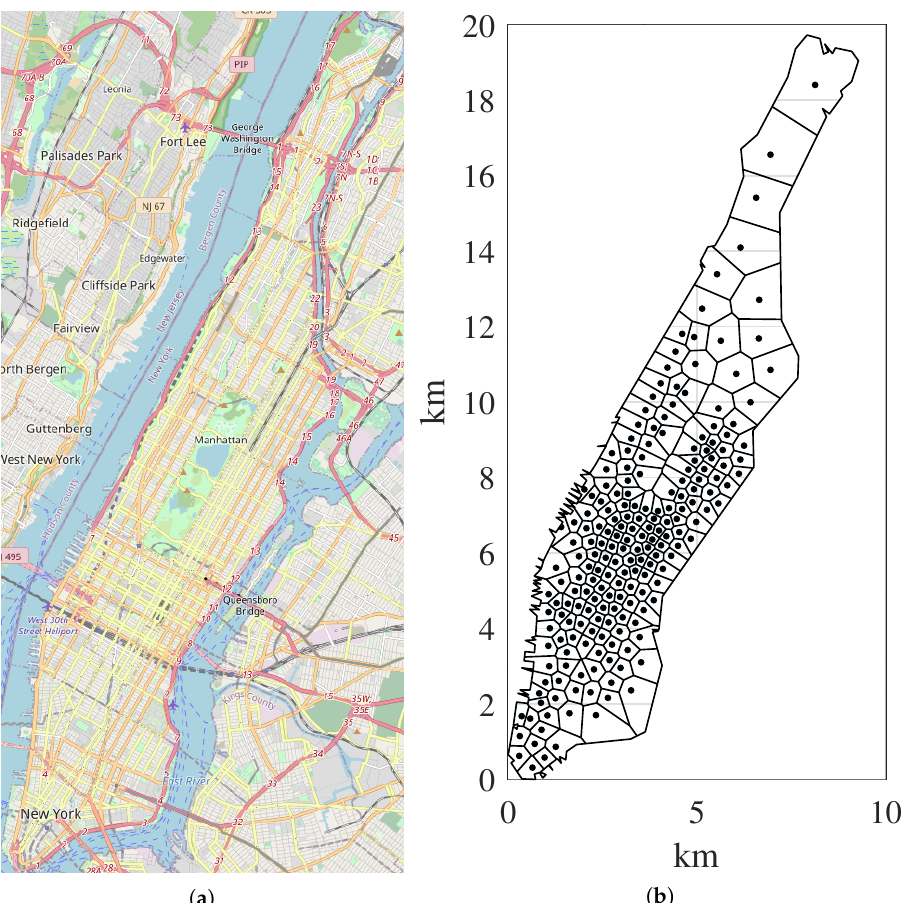
Figure 5. A map of ( a ) Manhattan; ( b ) the 200 zones and their centroids, in which we aggregated the trip origin and destination locations.